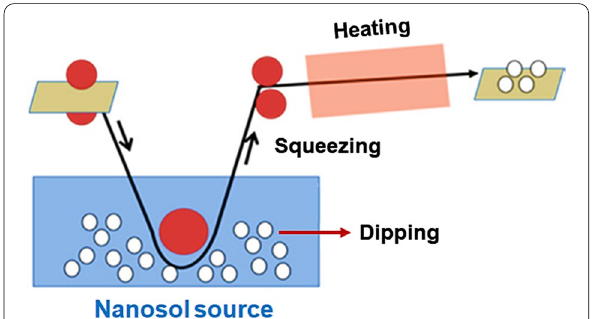
Fig. 4 Schematic representation of the dip-coating technique [62] Copyright 2015